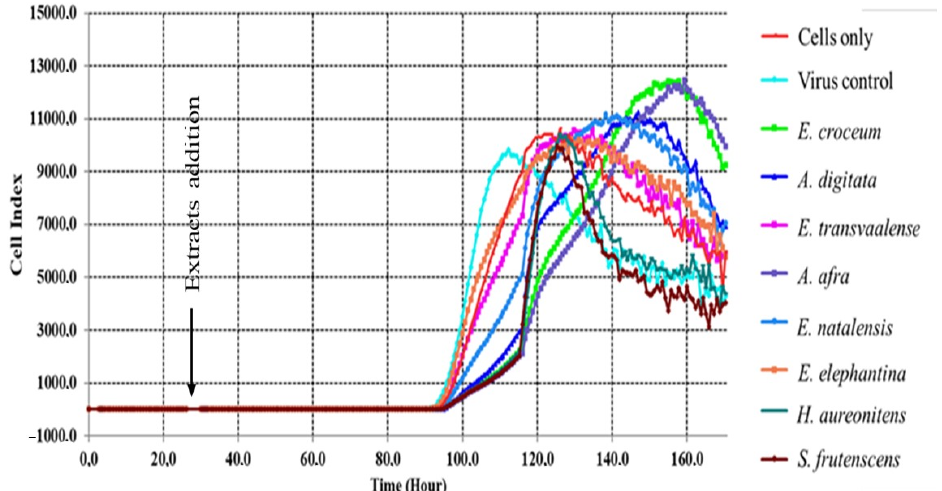
Figure 2. Real-time monitoring of the antiviral effects and cell growth in response to viral infection and/or extract treatment using the xCELLigence RTCA analyzer. Colored curves represent the Vero cells (control), viral-infected cells and extract (100 µg/mL) treated viral-infected Vero cells.